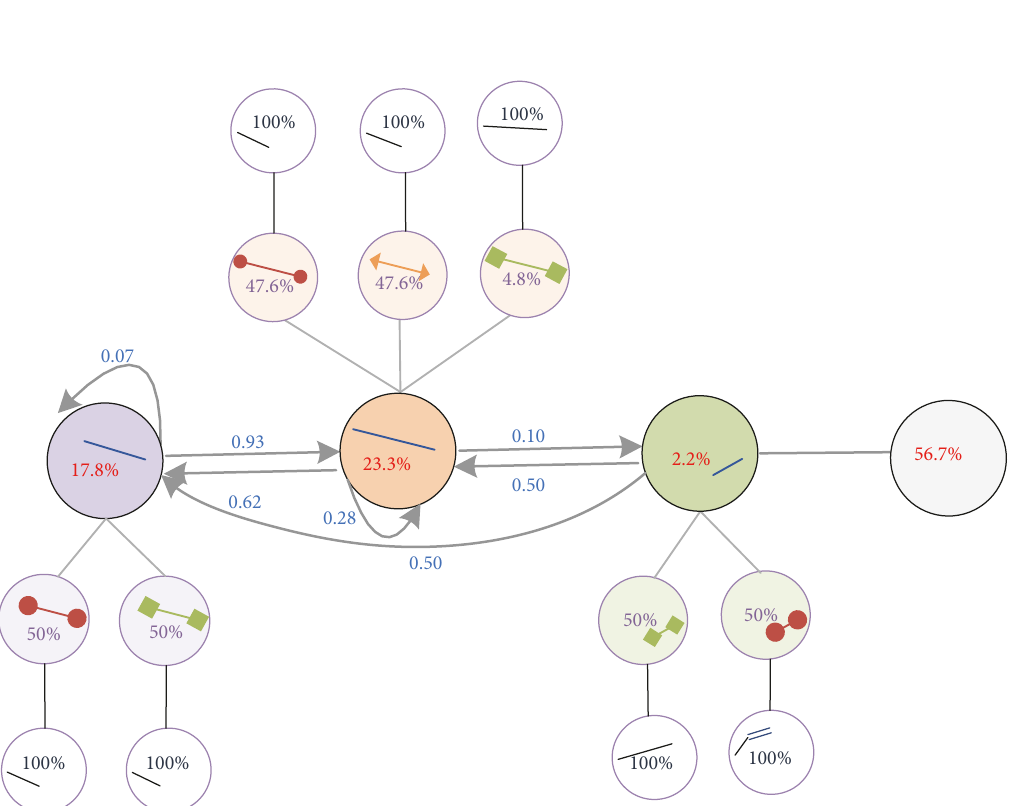
Figure 10: Individual travel behavior graph of passenger